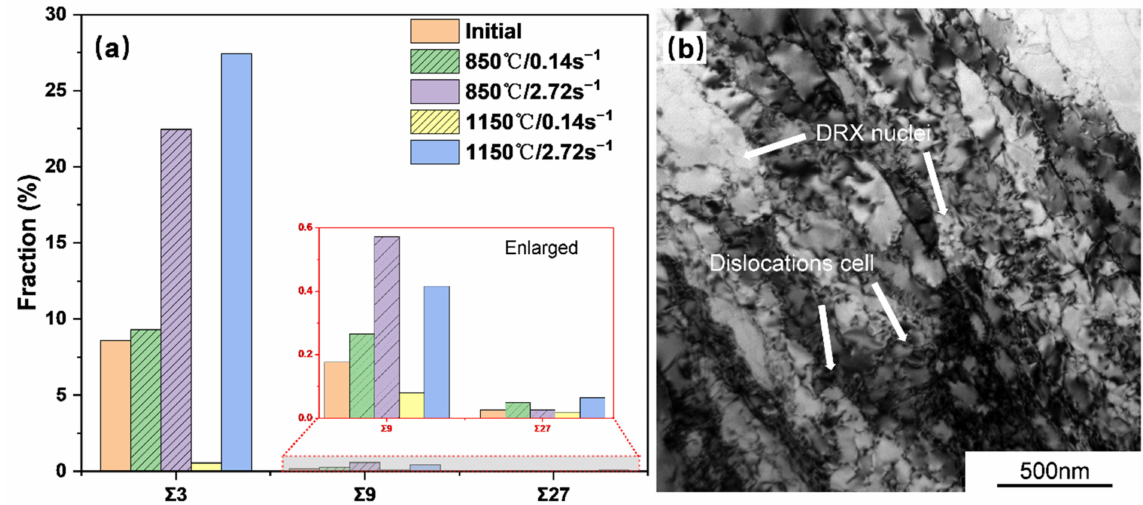
Figure 14. ( a ) Effect of hot deformation on the length fraction of the twin grain boundaries and ( b ) TEM micrographs.